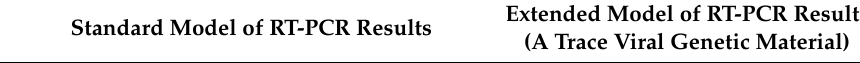
Table 2. Statement of results performed by Flu SensDx and